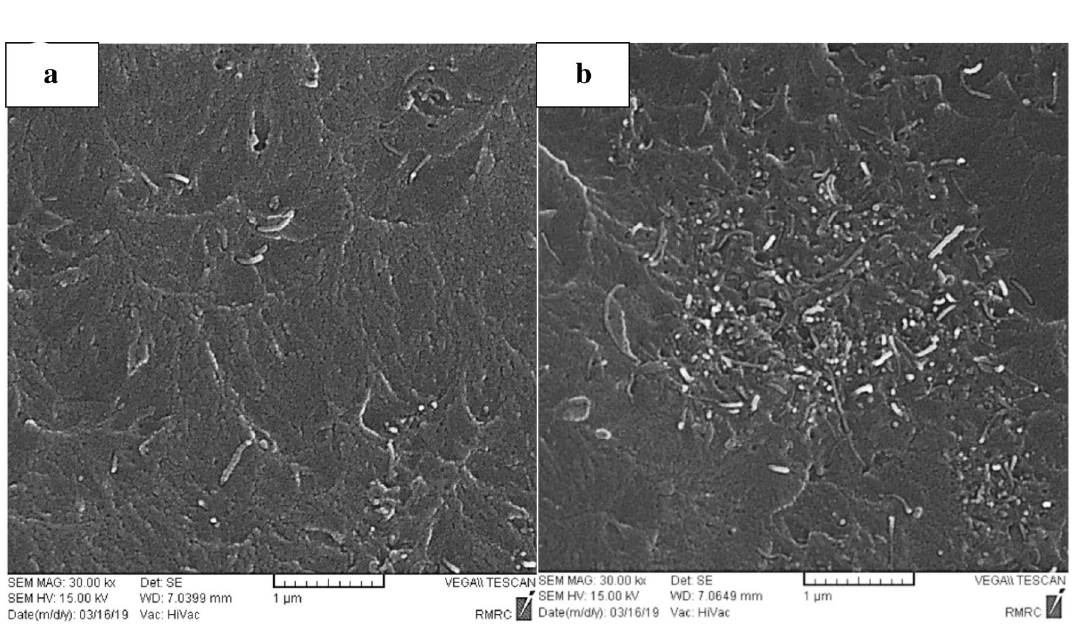
Fig. 5 The MWCNTs dispersion in nanocomposites ( a ) epoxy/0.5 Wt.% MWCNT and ( b ) epoxy/1.0 Wt.%